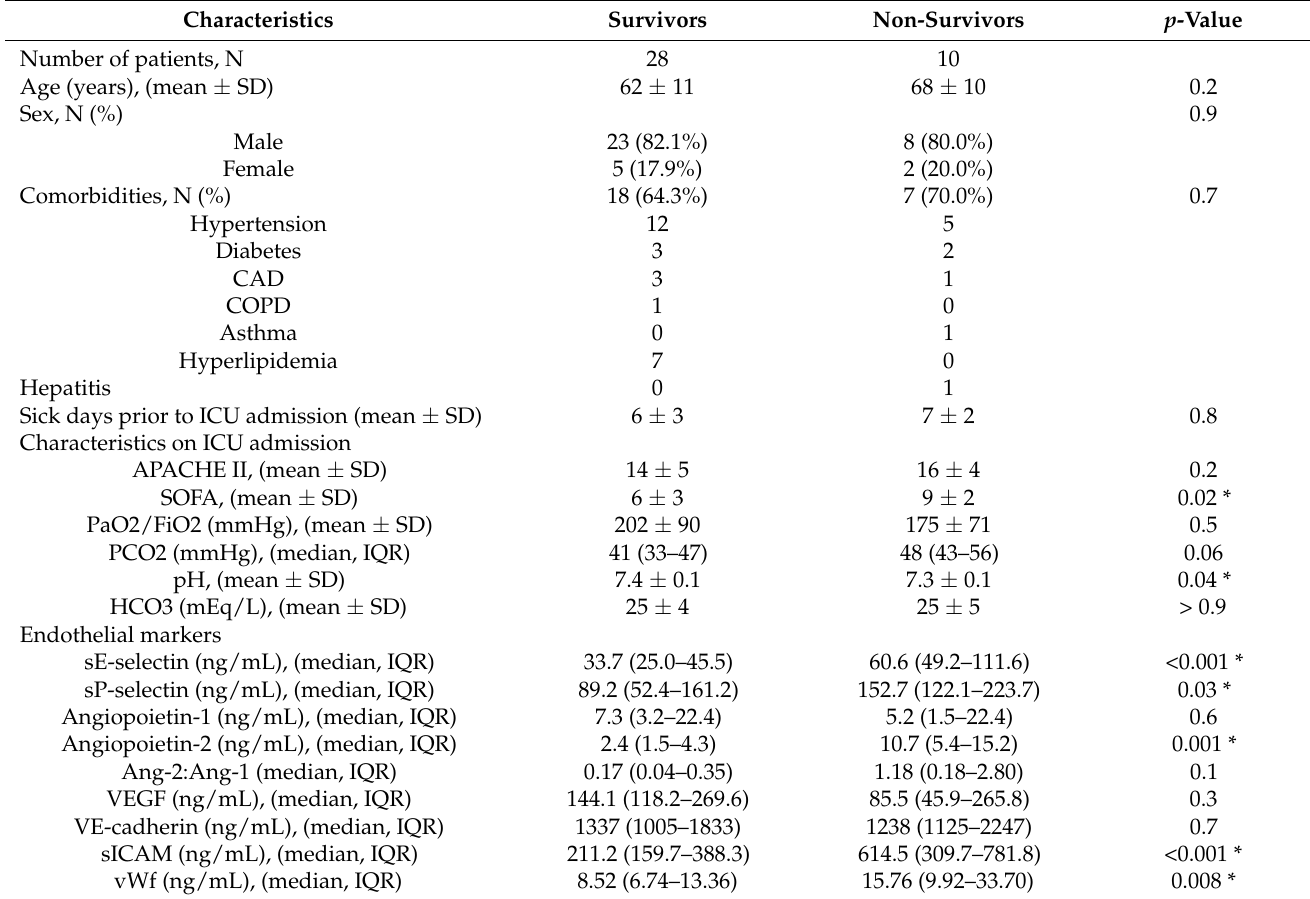
Table 2. Demographics, clinical characteristics, and endothelial biomarkers of the critically ill patients upon intensive care unit (ICU)